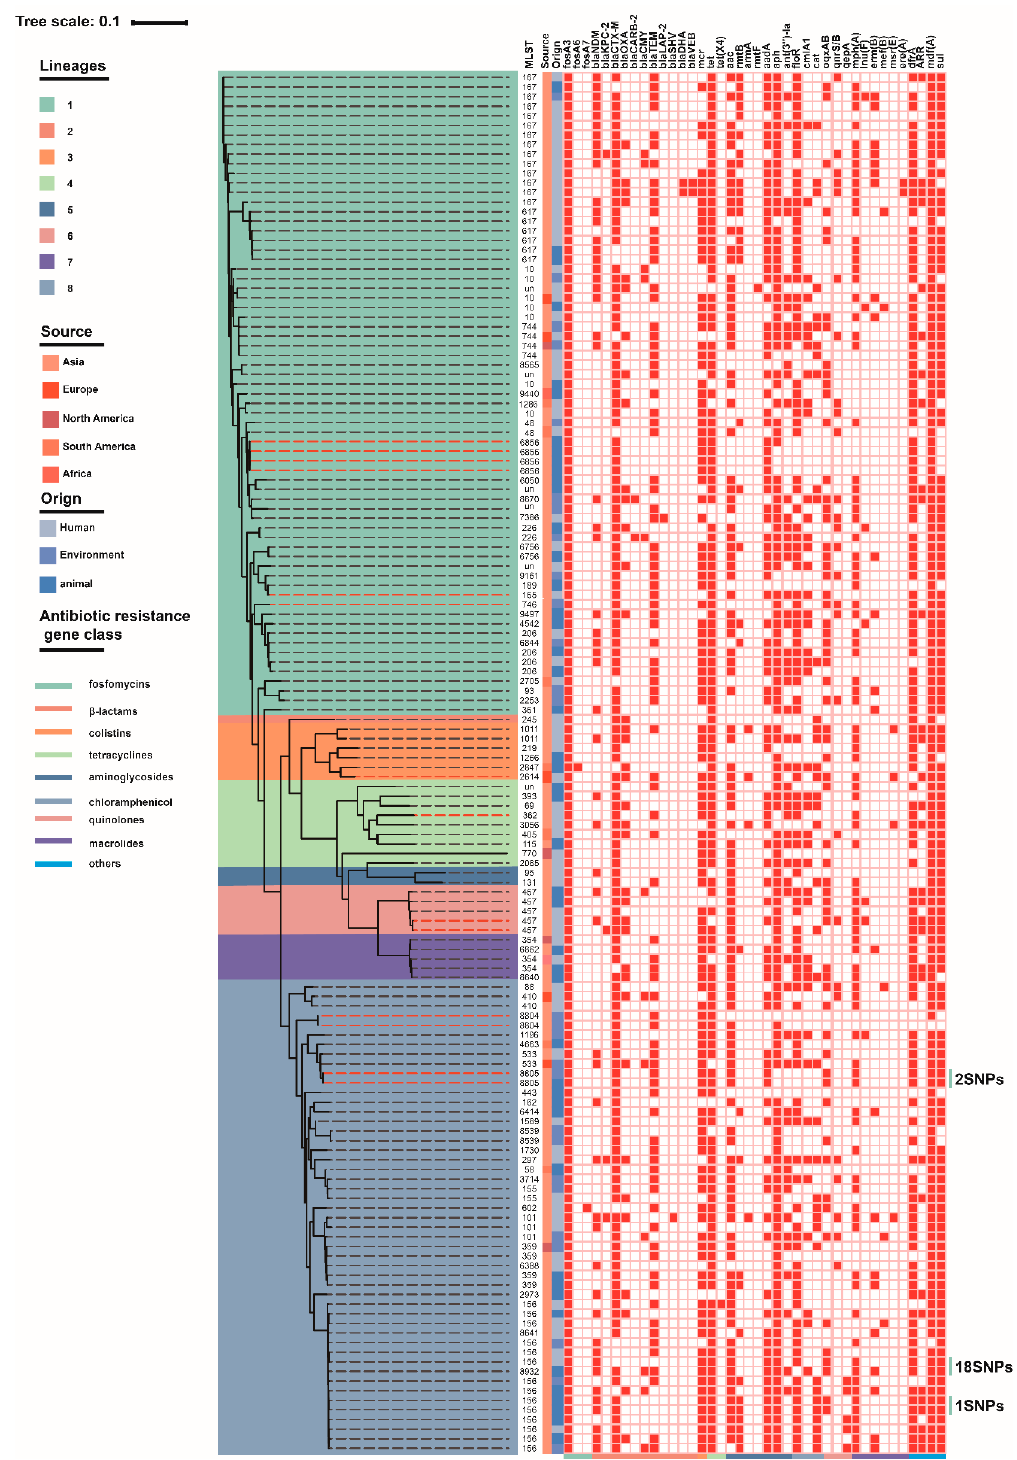
Figure 2. Phylogenetic tree along with ARGs present in the E. coli isolates. The phylogenetic tree is composed of 144 fosA3 -positive E. coli divided into eight clusters as indicted. The strains are marked with an orange dashed line in this study.